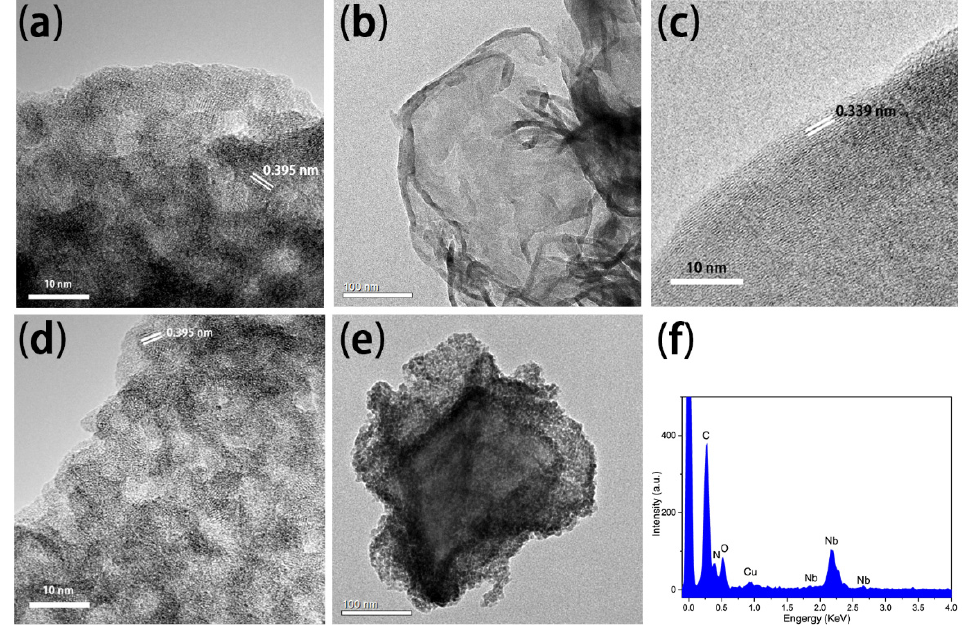
Figure 3. TEM images of: ( a ) mNb 2 O 5 ; ( b , c ) g-C 3 N 4 ; and ( d , e ) 4% g-C 3 N 4 -mNb 2 O 5 ; ( f ) EDS analysis of 4% g-C 3 N 4 -mNb 2 O 5 corresponding to ( e ).